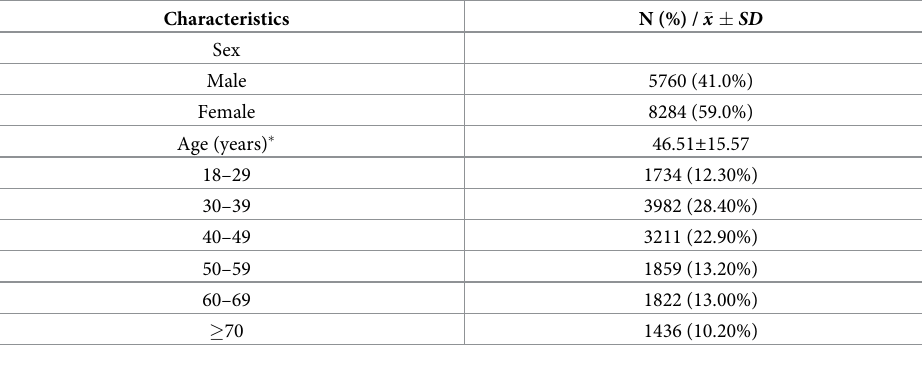
Table 1. Demographic characteristics of